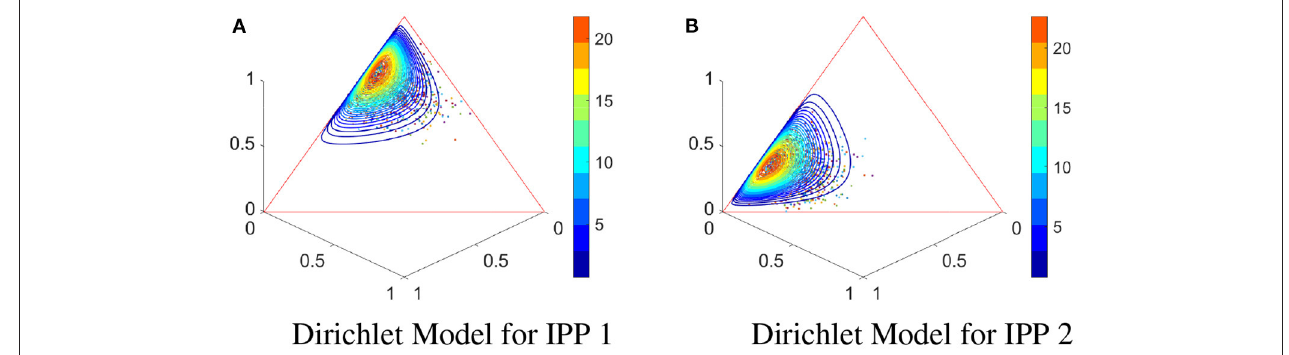
FIGURE 8 | Uni-modal IETs of 2-event realizations for IPP1 and IPP2 and single Gaussian models: (A) Ilr-transformed realizations of IPP1 given in Figure 7A and the fitted Gaussian contours. (B) Original realizations of IPP1 and ilr-inverse-transformed contours from the Gaussian contours in (A) . (C,D) Same as (A,B) except for IPP2.